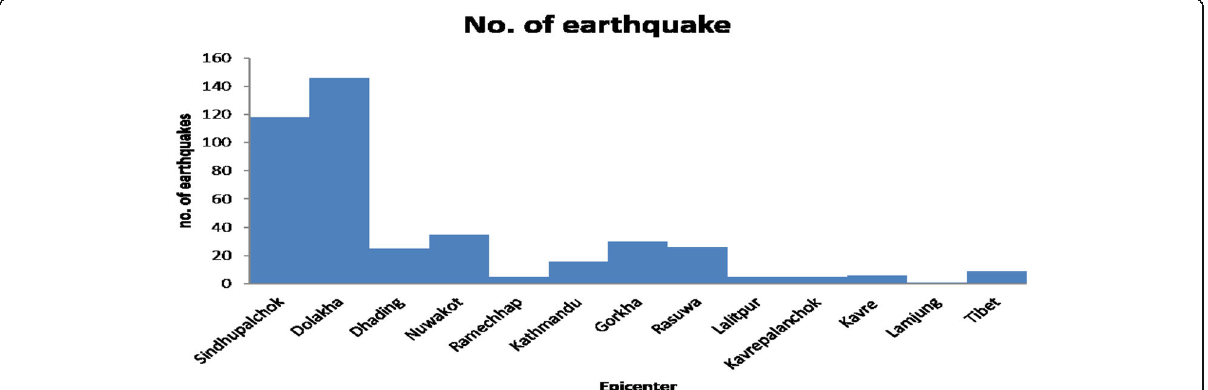
Fig. 1 Histogram of number of aftershock events occurred in different districts of Nepal after Gorkha, Nepal Earthquake 25 April 2015